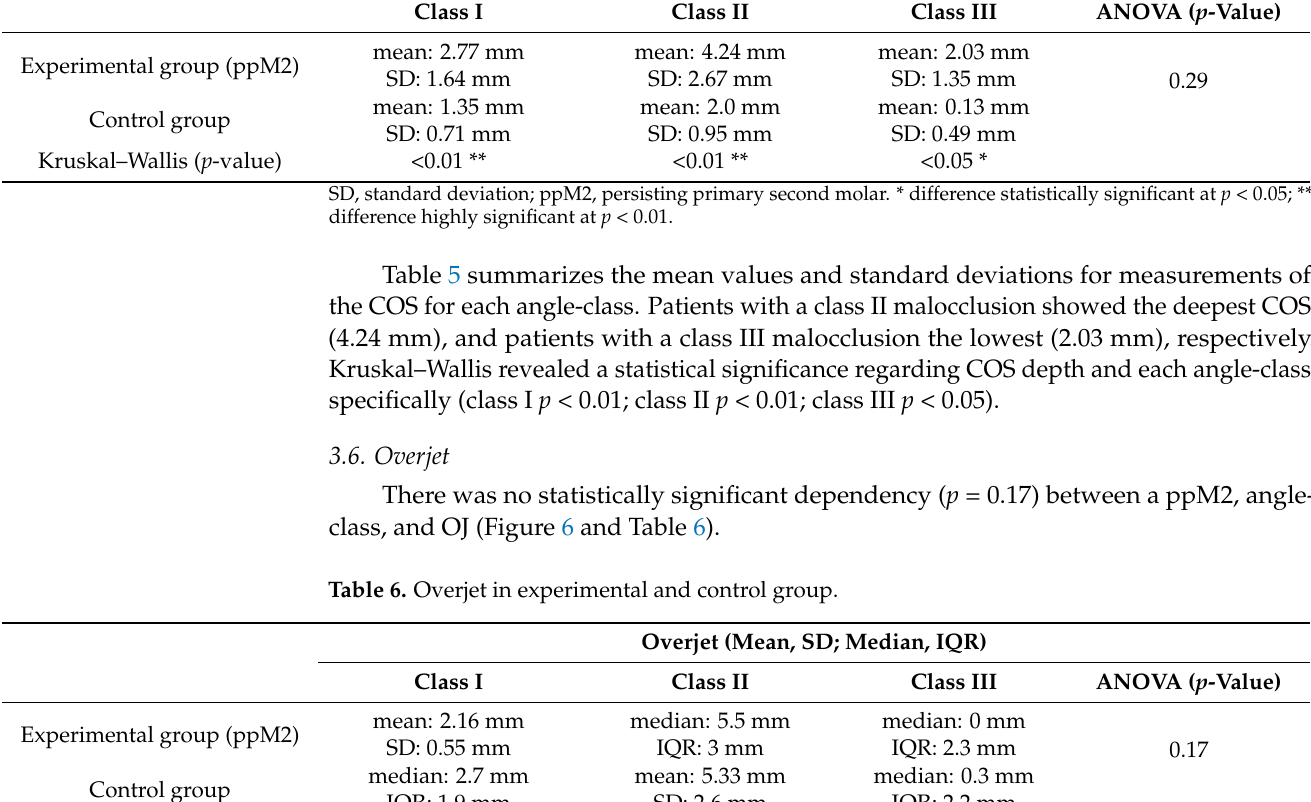
Table 5. COS depth and angle-classification in experimental and control group.